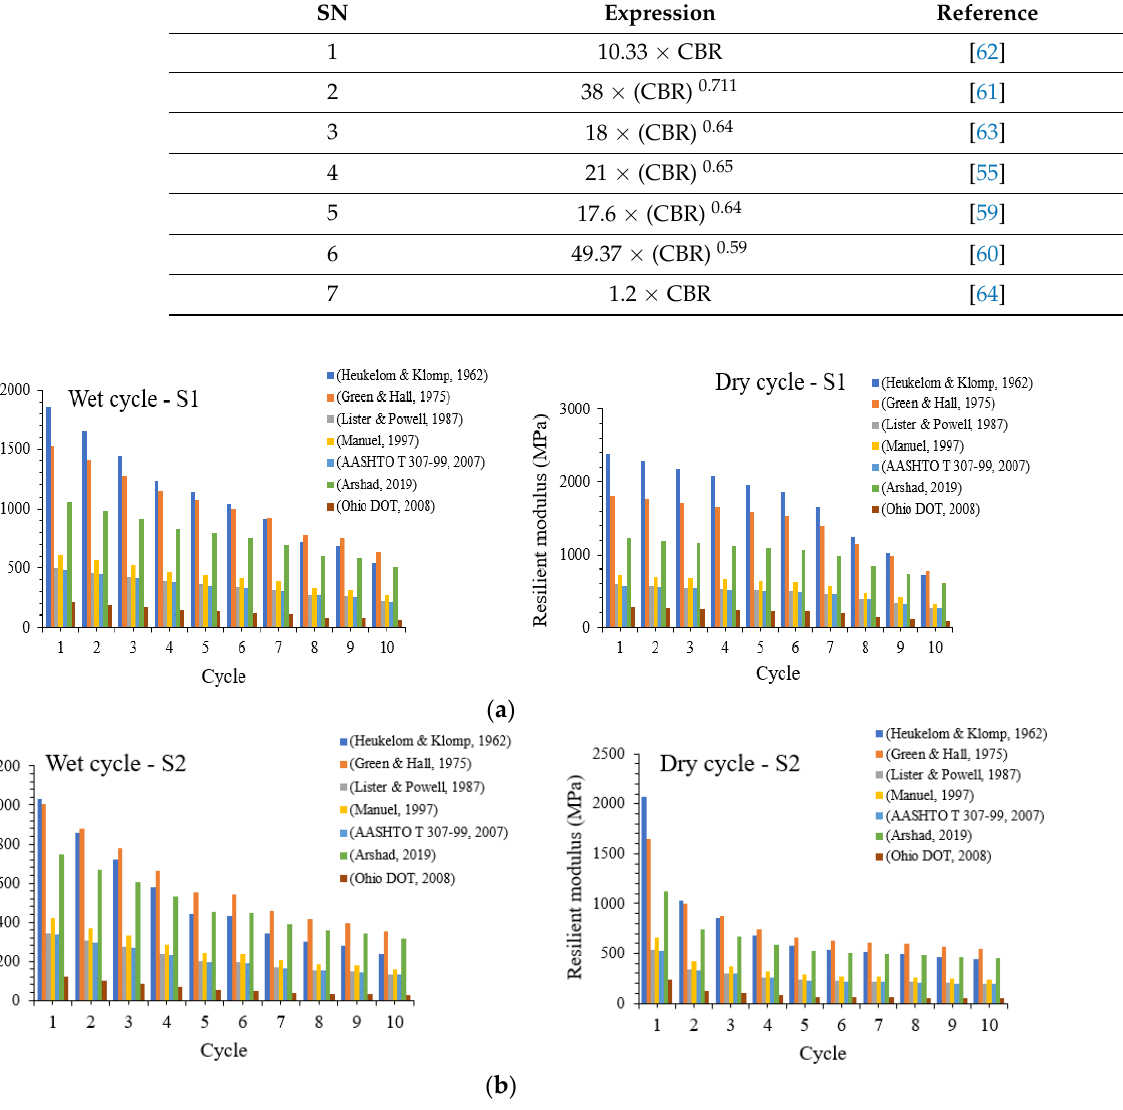
Figure 6. ( a ) Resilient modulus results for subgrade 1 composed of GGBS after 28 days of curing ( b ) Wetting – drying cycle results for subgrade 2 composed of GGBS after 28 days of curing [55,59 – 64].